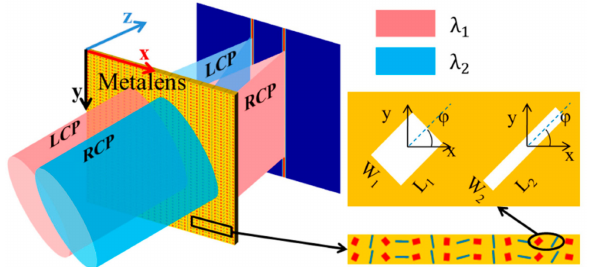
Figure 2. Schematic of the spin-selected dual-wavelength metalens for focusing di ff erent circularly polarized light with di ff erent